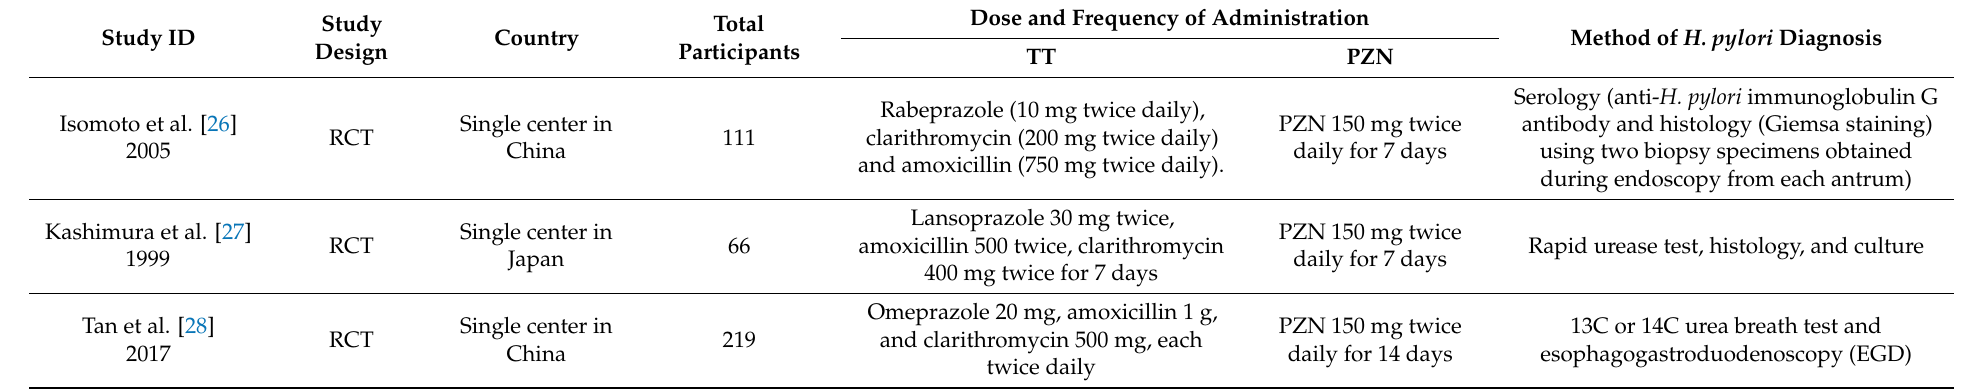
Table 2. Characteristics of the included studies.